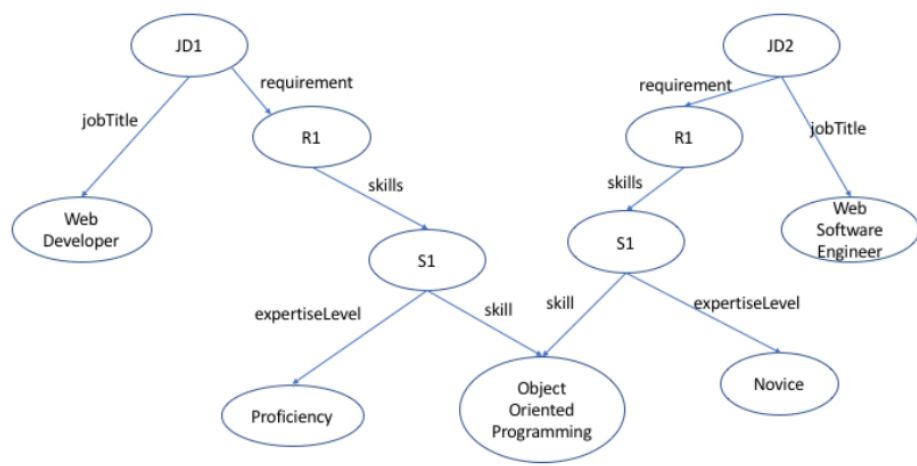
Figure 6. Graph structure showing entities and connections between the extracted entities to build a context in